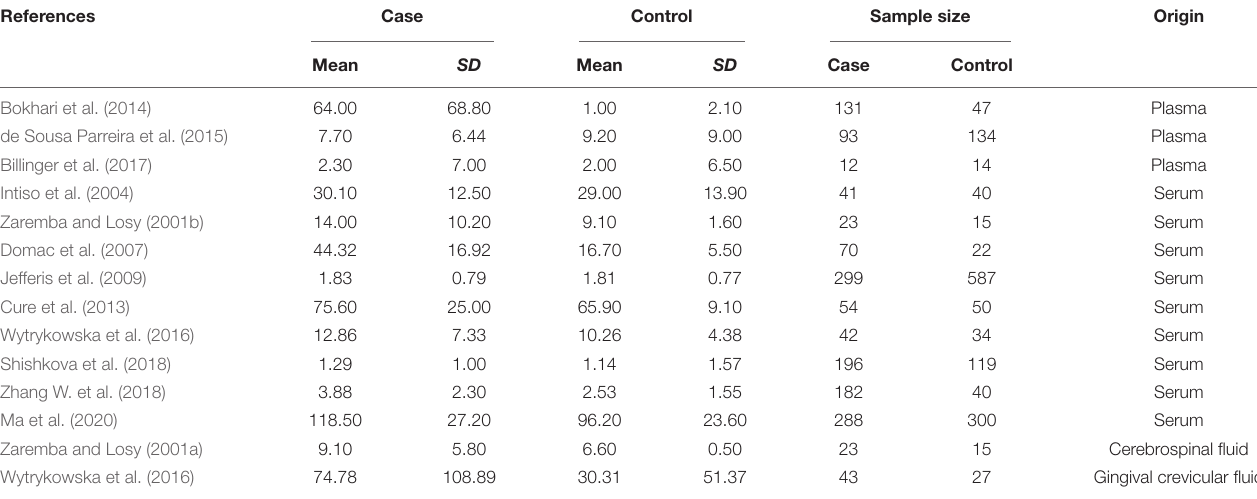
TABLE 2 | Summary of studies exploring the relationship between the levels of TNF- α and